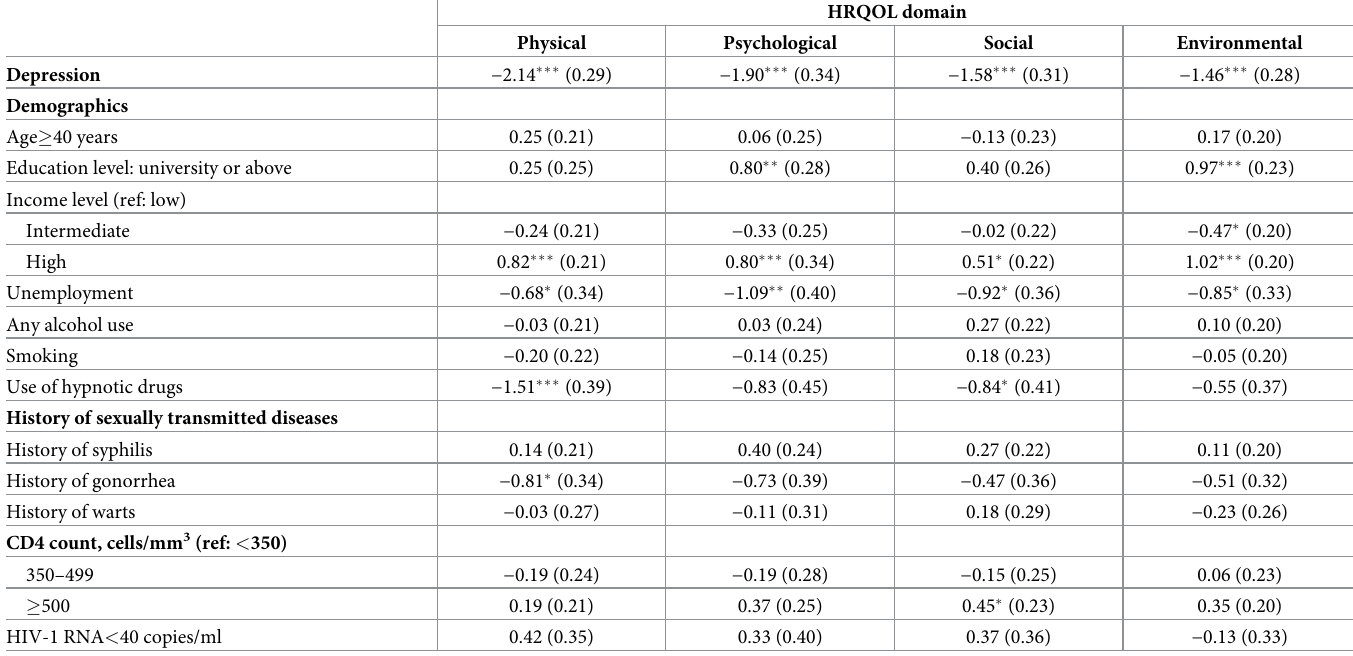
This study found that 14.0% of the HIV-infected MSM had depression. The proportion of nonadherence to ART was 21.8% and 10.5% in the depressed and nondepressed HIV-infected MSM, respectively. Moreover, physical, psychological, social, and environmental HRQOL in HIV-infected MSM was negatively associated with depression. After adjusting for the demo- graphic characteristics and other covariates, the HIV-infected MSM with depression had poor adherence to ART and poor HRQOL. When the use of antidepressant therapy was considered, the depressed HIV-infected MSM who did not receive antidepressant therapy had poor adher- ence to ART and worse HRQOL than those who did have antidepressant therapy. Table 4. Regression coefficients (standard errors) from the bivariate linear regression analyses of the health-related quality of life among HIV-infected MSM. HRQOL